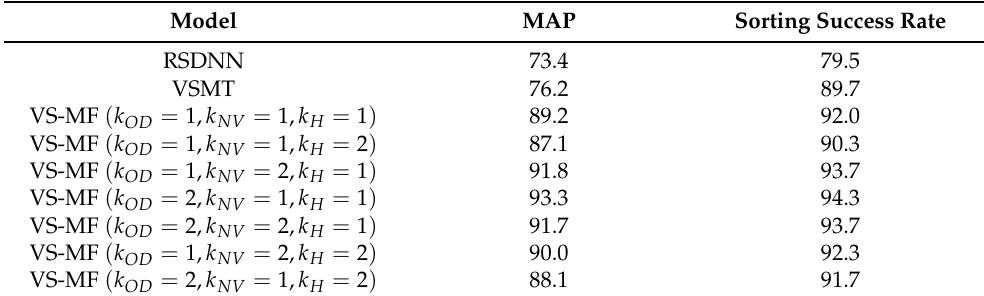
Table 6. The performances of different strategies for sorting order in sorting success rate and sys- tem